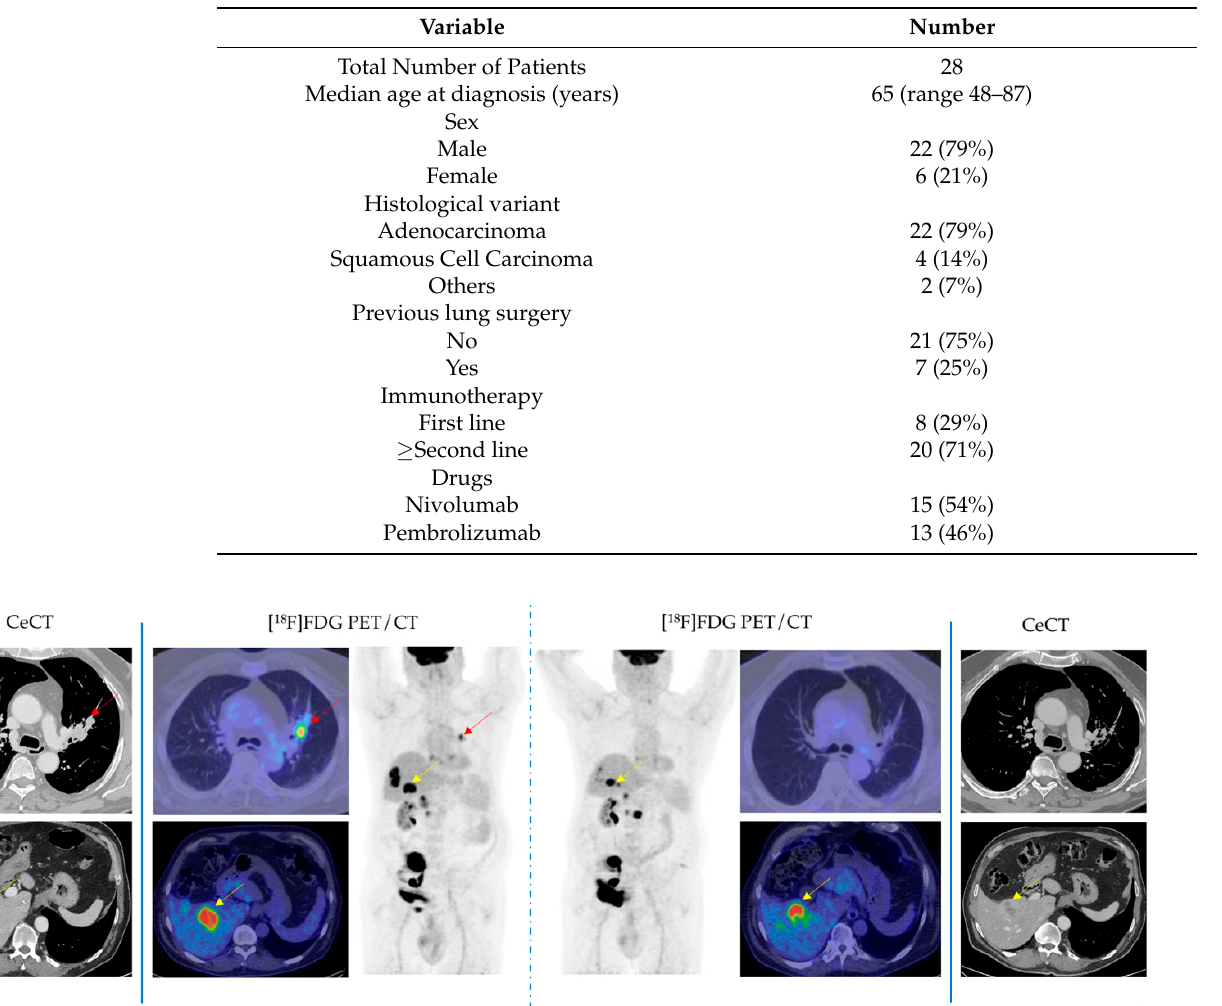
Table 1. Patients’ characteristics.